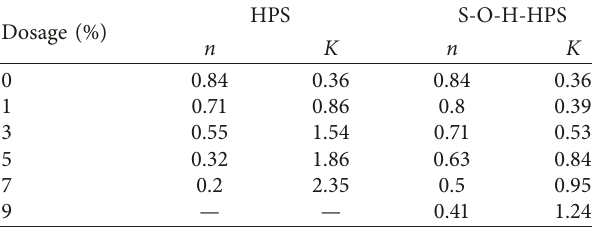
Figure 3: FT-IR spectra of acid-activated HPS fiber and coupling agent modification-sulfonation modification. Table 3: Rheological properties of modified cement